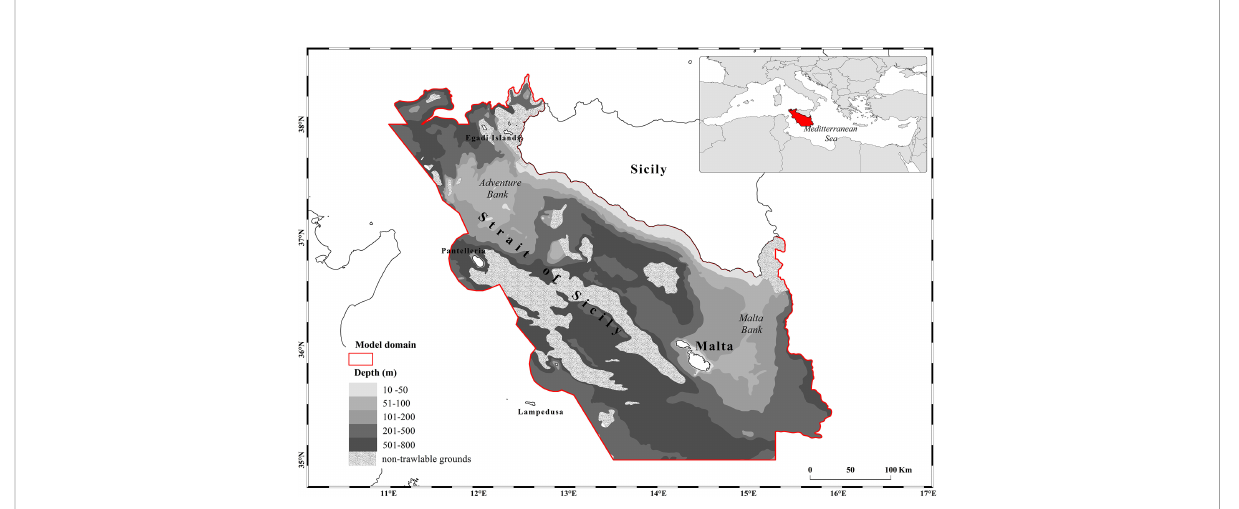
FIGURE 1 Area of the Strait of Sicily where the dynamic food web model (about 61,000 km2) is